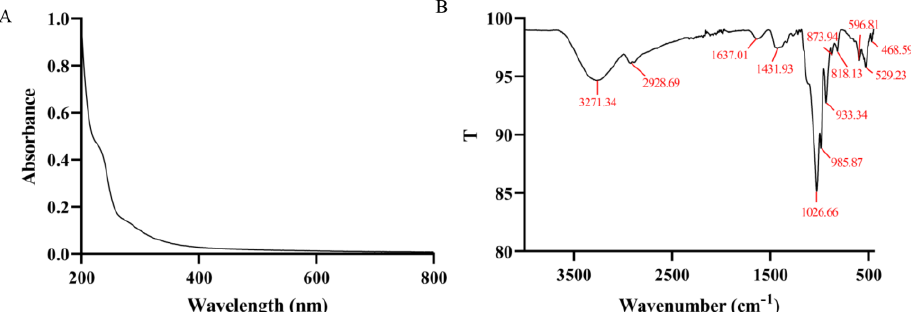
Figure 2. ( A ) UV−vis spectrum of cMORP in the range of 200−800 nm; ( B ) FT−IR spectrum of cMORP Figure 2. ( A ) UV − vis spectrum of cMORP in the range of 200–800 nm; ( B ) FT − IR spectrum of in the range of 4000−450 cm −1 . cMORP in the range of 4000–450 cm − 1